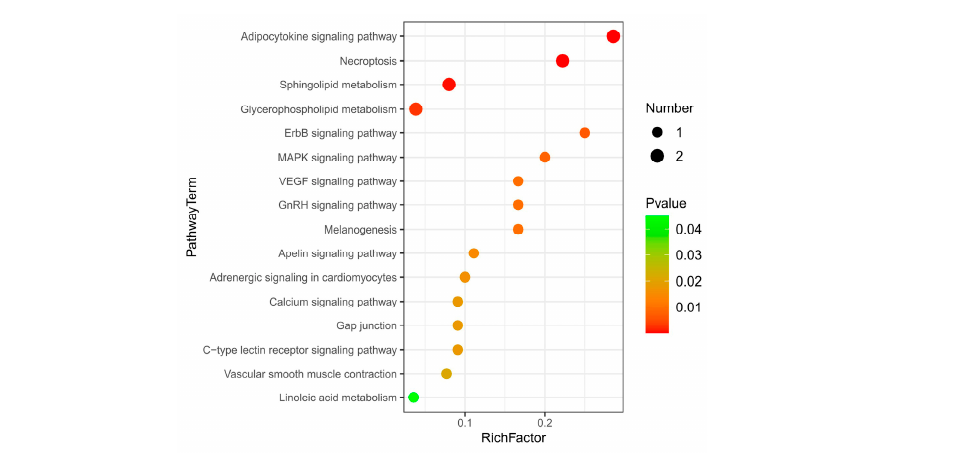
Figure 4. KEGG pathway enrichment of liver differential metabolites between Huainan Partridge chicken (LC) and Nongda III (CC). Table 3. Differential metabolites identified in liver from Huainan Partridge chicken and Nongda